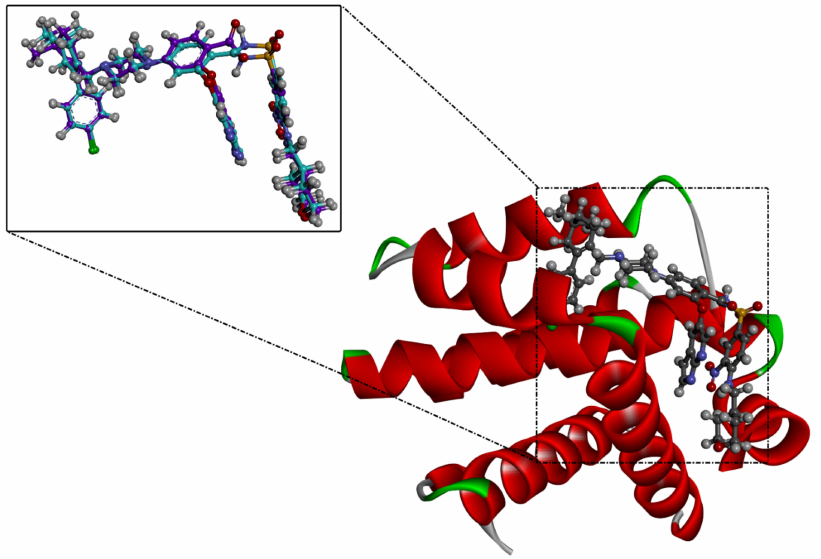
Figure 1. Three-dimensional superimposition of the resolved experimental structure (in mauve) and the anticipated binding mode (in cyan) of venetoclax complexed with Bcl-2